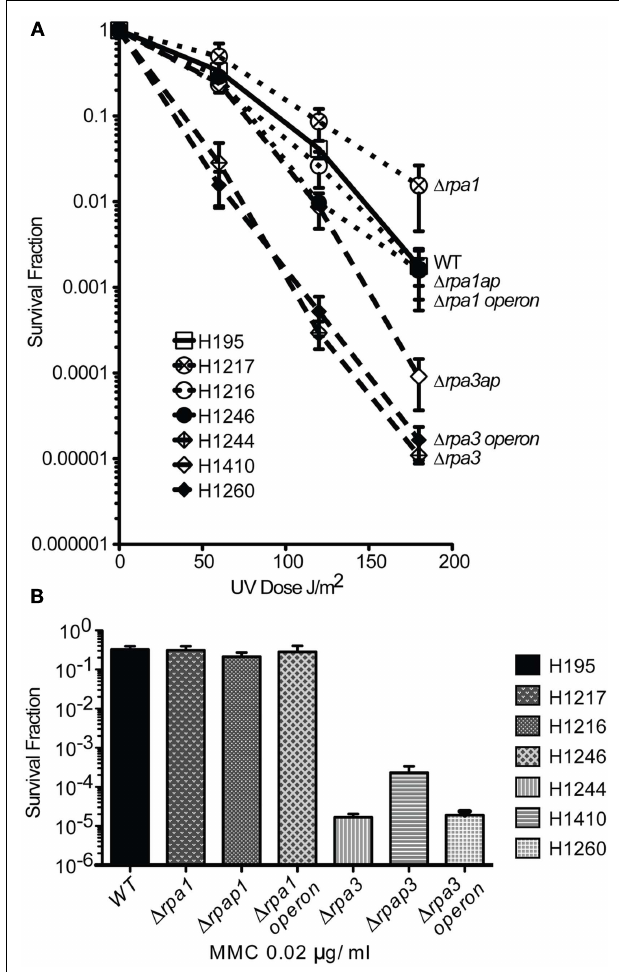
FIGURE 4 | (A) Wild-type (WT), rpa1 , rpap1 , rpa1 operon, rpa3 , rpap3 , rpa3 operon (H195, H1217, H1216, H1246, H1244, H1410, and H1260, respectively), were plated out and exposed to ultraviolet (UV) radiation.The average and standard error (SE) of three experiments are shown. (B) The strains shown in (A) were plated out and exposed to mitomycin C (MMC). The average and SE of three experiments are shown.